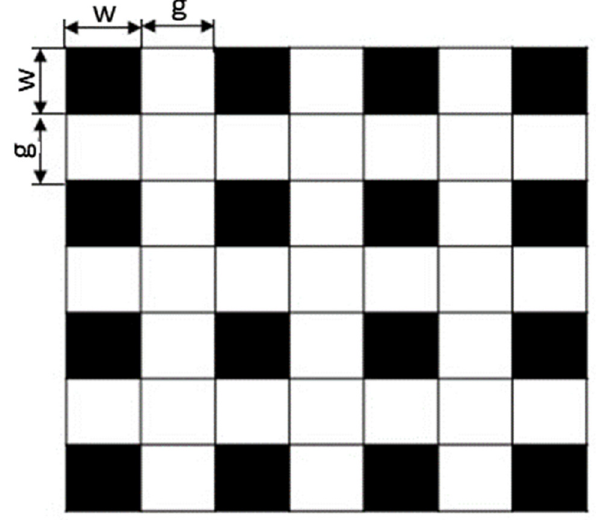
Figure 5. Schematic diagram of the superhydrophobic surface (black: no slip wall and white: SHS).